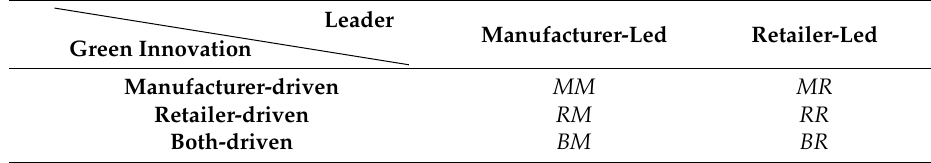
Table 2. Six Stackelberg game